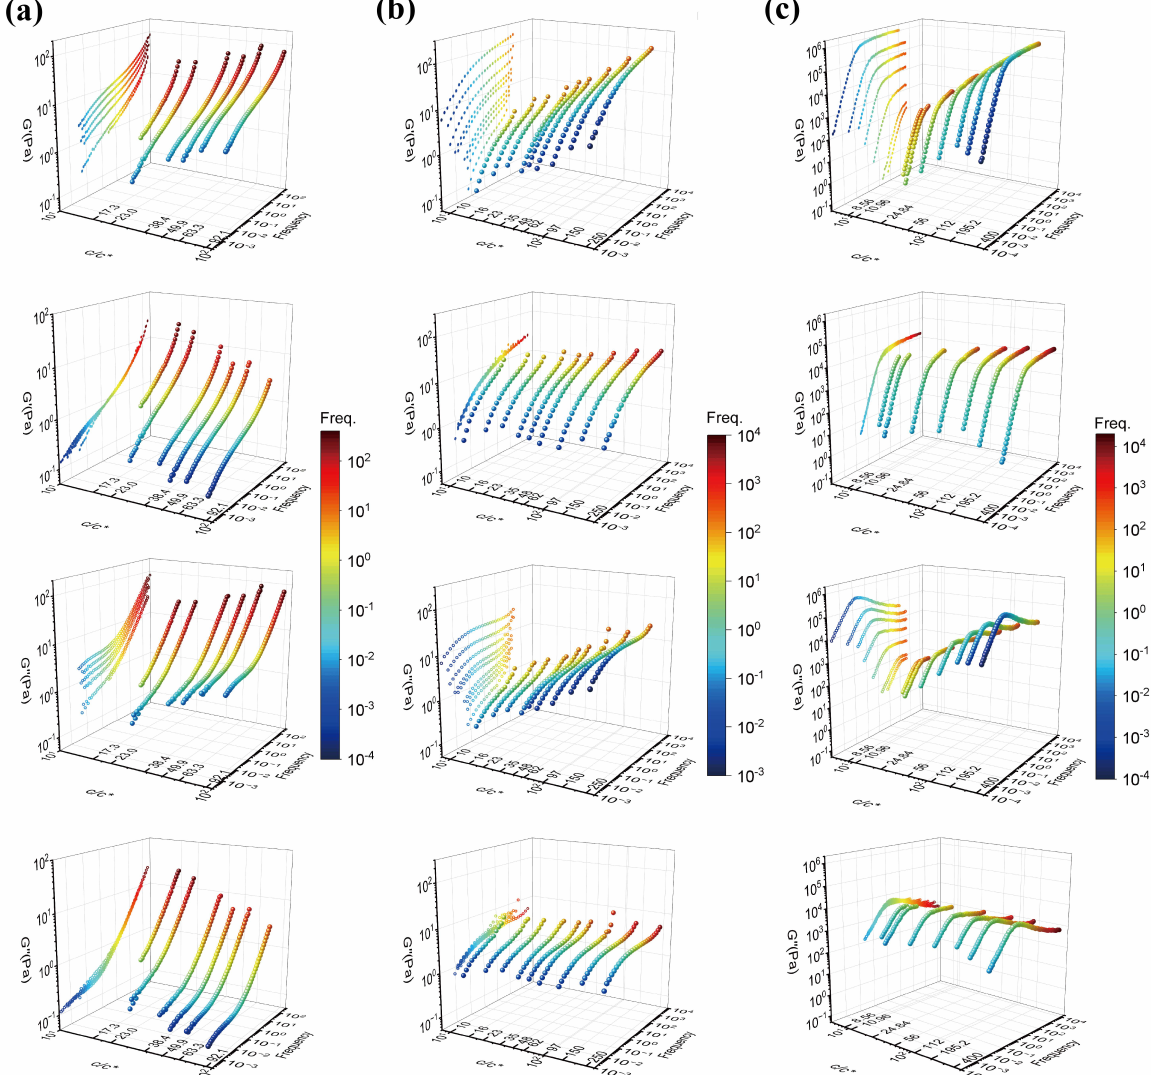
Figure 2. Three–dimensional plots of G (cid:48) and G (cid:48)(cid:48) against concentration and frequency. ( a ) 18M PAAm– sucrose–water ternary solution; ( b ) 18M PAAm–water solution [11]; and ( c ) PB–PHO solution [4], respectively. The first row and the third row show the curves before TCS shifting. The second row and the fourth row show the curves after TCS shifting. The color scheme indicates the scale of frequency. The master curves are projected in the G (cid:48) – or G (cid:48)(cid:48) –Freq